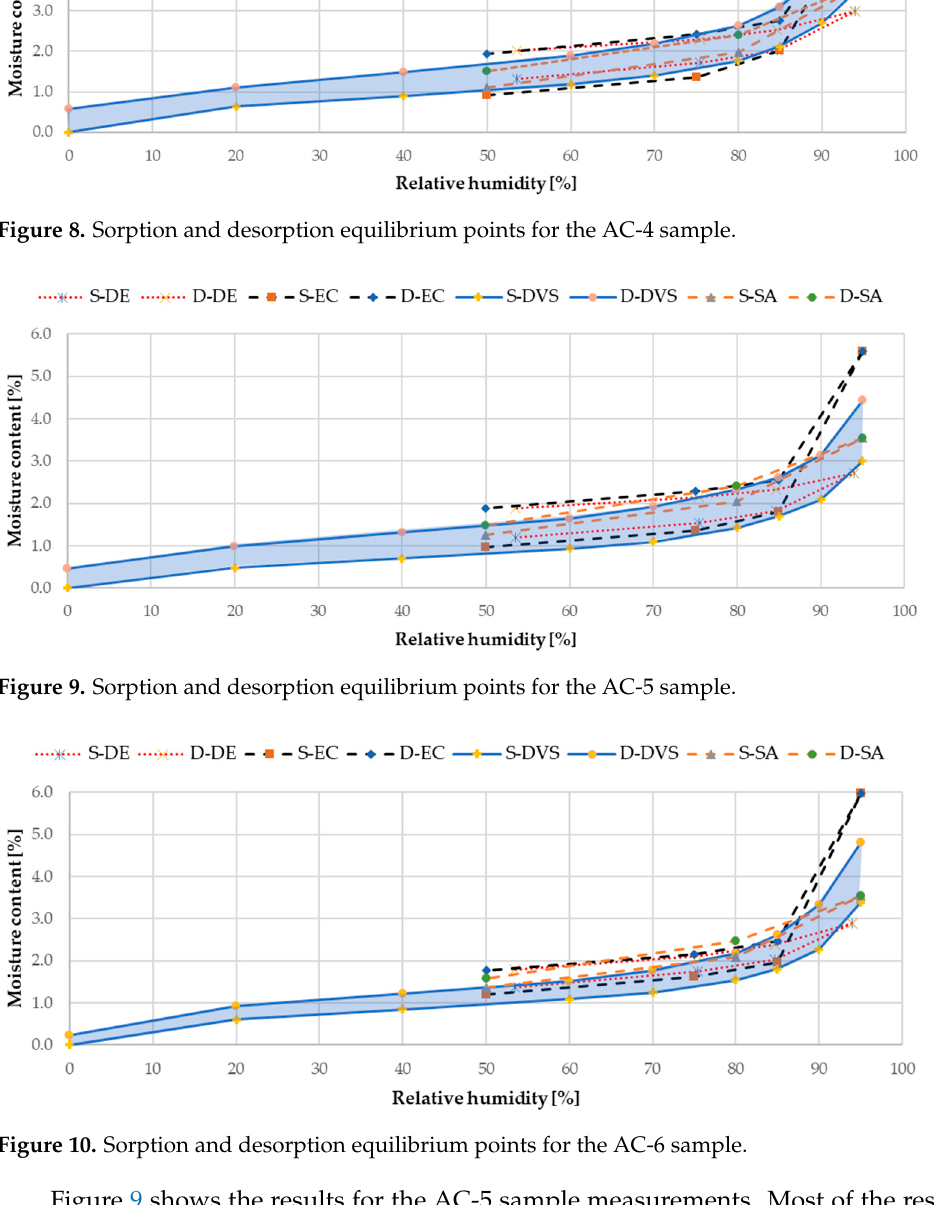
Figure 8. Sorption and desorption equilibrium points for the AC-4 sample.